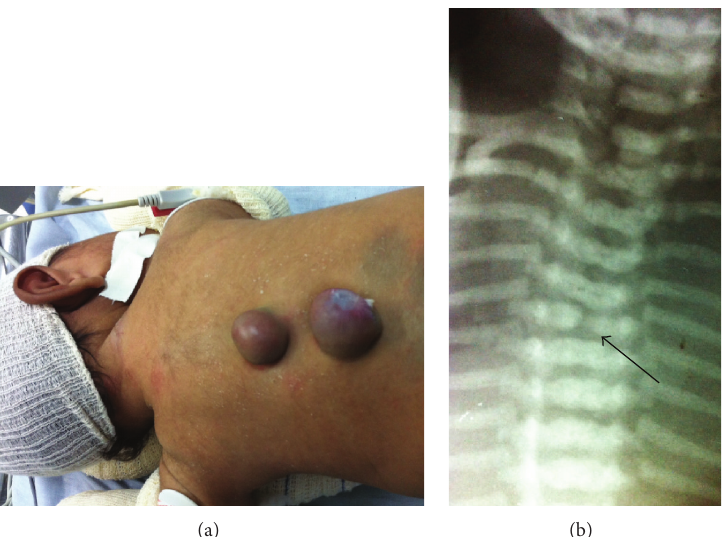
Figure 3: (a) A newborn with multiple thoracic myelomeningocele. (b) Plain radiograph of the chest, showing a reduction and a fissure in the body of the fifith thoracic